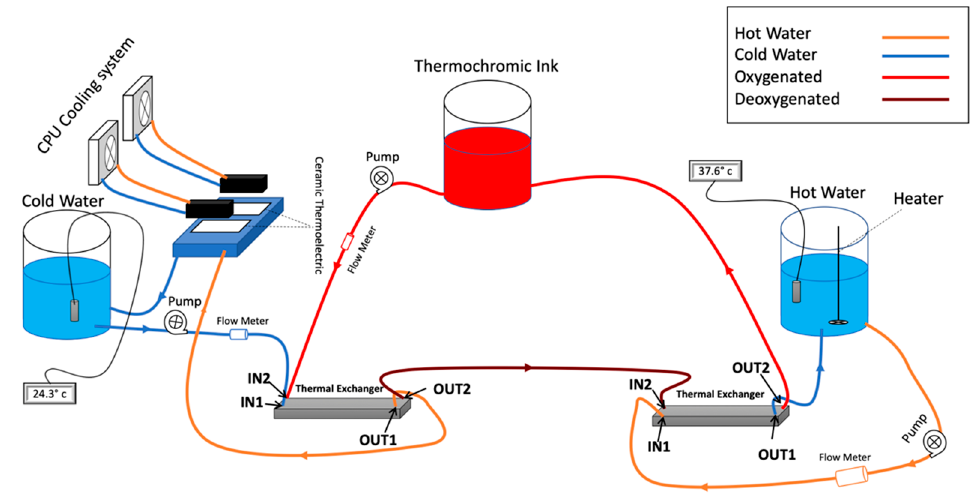
Figure 3. Heater/cooler block diagram